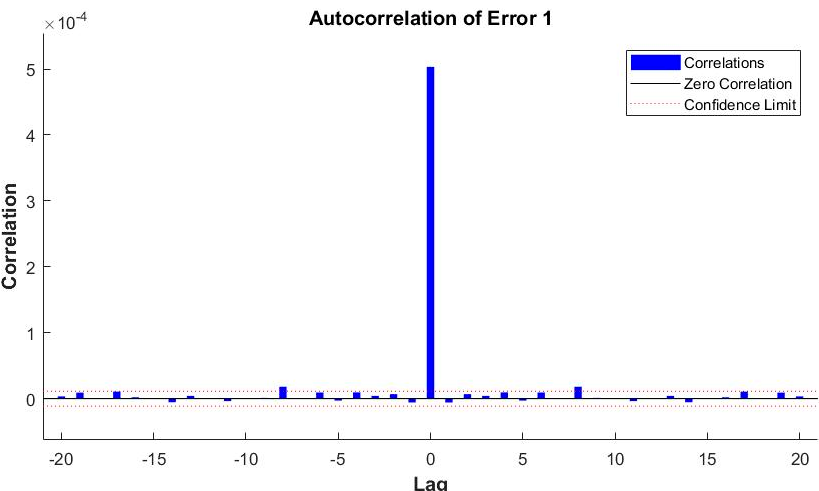
Figure 18. The error autocorrelation function when forecasting the electricity consumption for the month of December, using the ANN_NARX_BR_TS network.